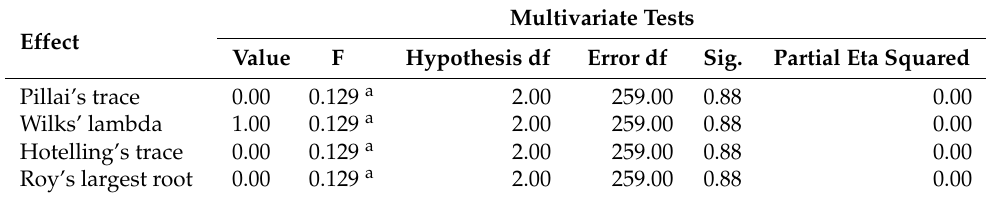
Table 5. Environment benefits of adopting biogas